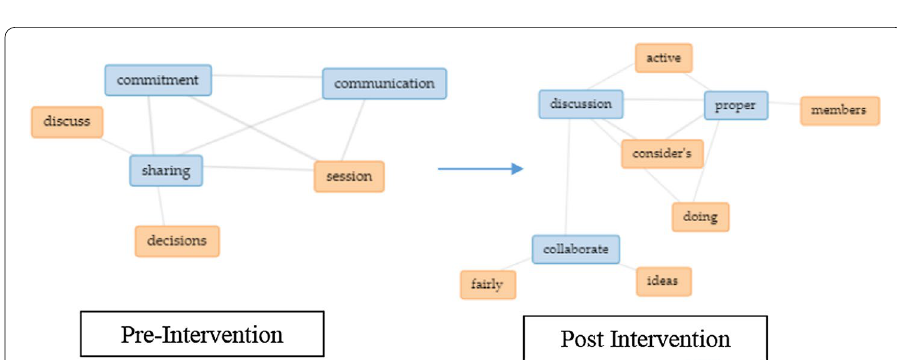
Fig. 13 Changes in perception for the EC group based on recommendations for learning improvement as a team